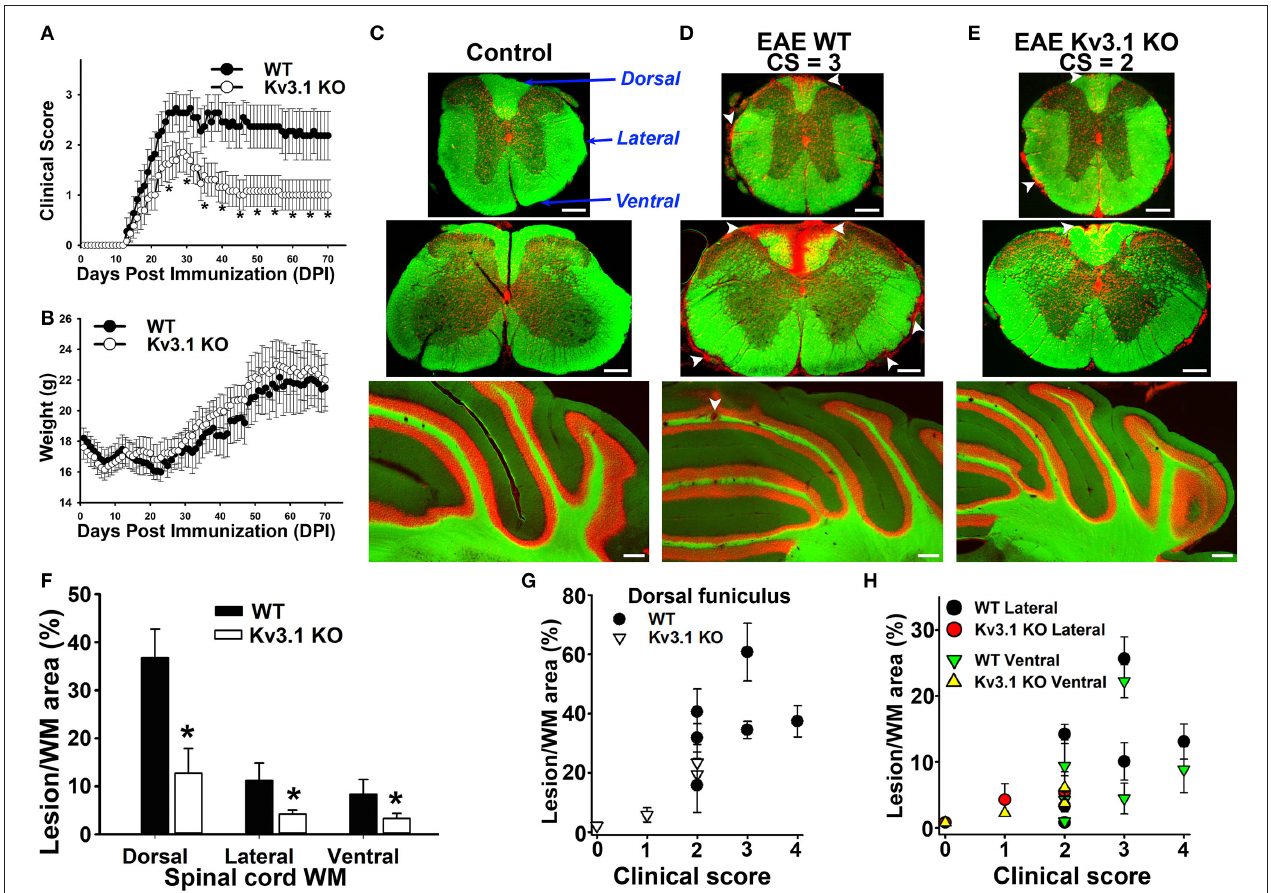
FIGURE 1 | Deleting Kv3.1 channel reduces EAE severity through lesion reduction. (A) Reduction of EAE severity in Kv3.1 KO mice ( n = 9) compared to WT mice ( n = 8). (B) Alterations of mouse body weight during EAE progression. (C) EAE lesions in control mice. Cross sections of spinal cord (top, thoracic; middle, cervical) and coronal section of the cerebellum (bottom) were stained with FluoroMyelin Green (FMG; green) and nuclear dye (Hoechst; red). CS, clinical score. Dorsal, lateral, and ventral funiculi were indicated with blue arrows. (D) EAE lesions at the late stage in WT mice. (E) EAE lesions at the late stage in Kv3.1 KO mice. White arrowheads, lesions. Scale bars, 250 µ m. (F) The summary of EAE lesion areas in dorsal, ventral and lateral funiculi white matter in WT and Kv3.1 KO mice. EAE mice at 60 DPI were examined. Unpaired t –test: * p < 0.05. (G) Correlations between clinical scores and lesion areas in WT and Kv3.1 KO mice in dorsal funiculus. (H) Correlations between clinical scores and lesion areas in WT and Kv3.1 KO mice in lateral and ventral funiculi. (C–H) 6 wild type mice and 4 Kv3.1 KO mice were used. About 20 images for each mouse were used for quantification of lesion